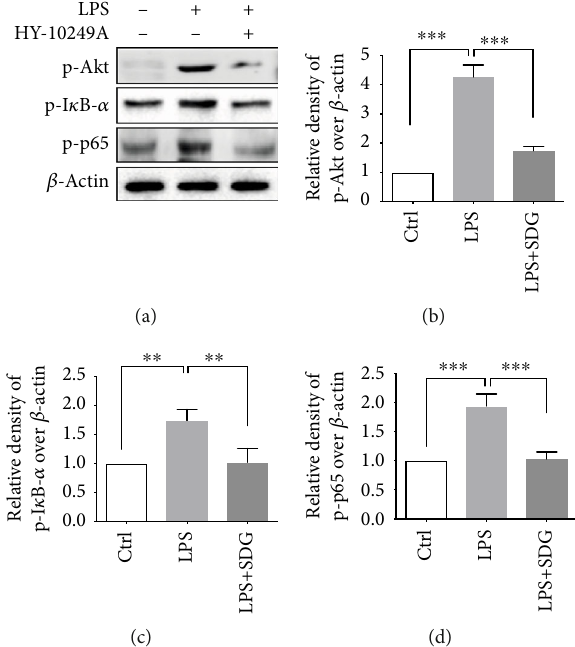
Figure 6: E ff ects of SDG on the protein expression of Akt in LPS-induced HUVECs. (a) Representative immunoblots of p- Akt, p-I κ B- α , and p-NF- κ B p65 in di ff erent groups. (b – d) Semiquantitative analysis of (a) by densitometric analysis. Error bars represent mean ± s : d . ∗∗ and ∗∗∗ represent p < 0 : 01 and p < 0 : 001 , respectively. All experiments were performed in triplicate. LPS: lipopolysaccharide; SDG: secoisolariciresinol